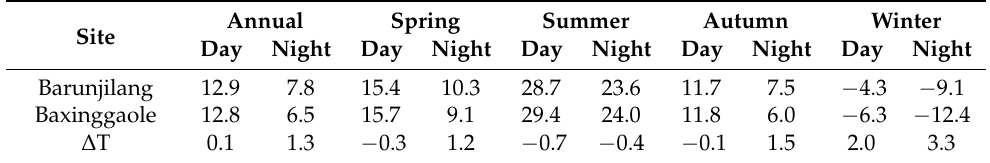
Table 3. Comparison of day and night temperatures in the year and in winter between lake and non-lake areas (unit: ◦